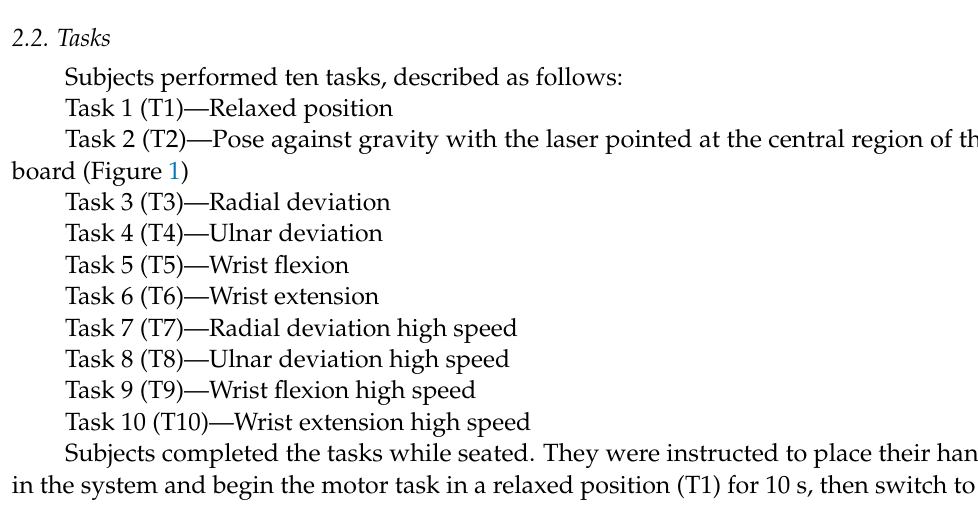
Figure 1. A 2-dimensional array of NCC sensors. Each sensor pair provides information regarding motion along the y and z axes, represented by the red arrows. A board with markers was placed in the background to aid the subject during the execution of experimental tasks. Orange arrows indicate the location of the four EPIC sensors.